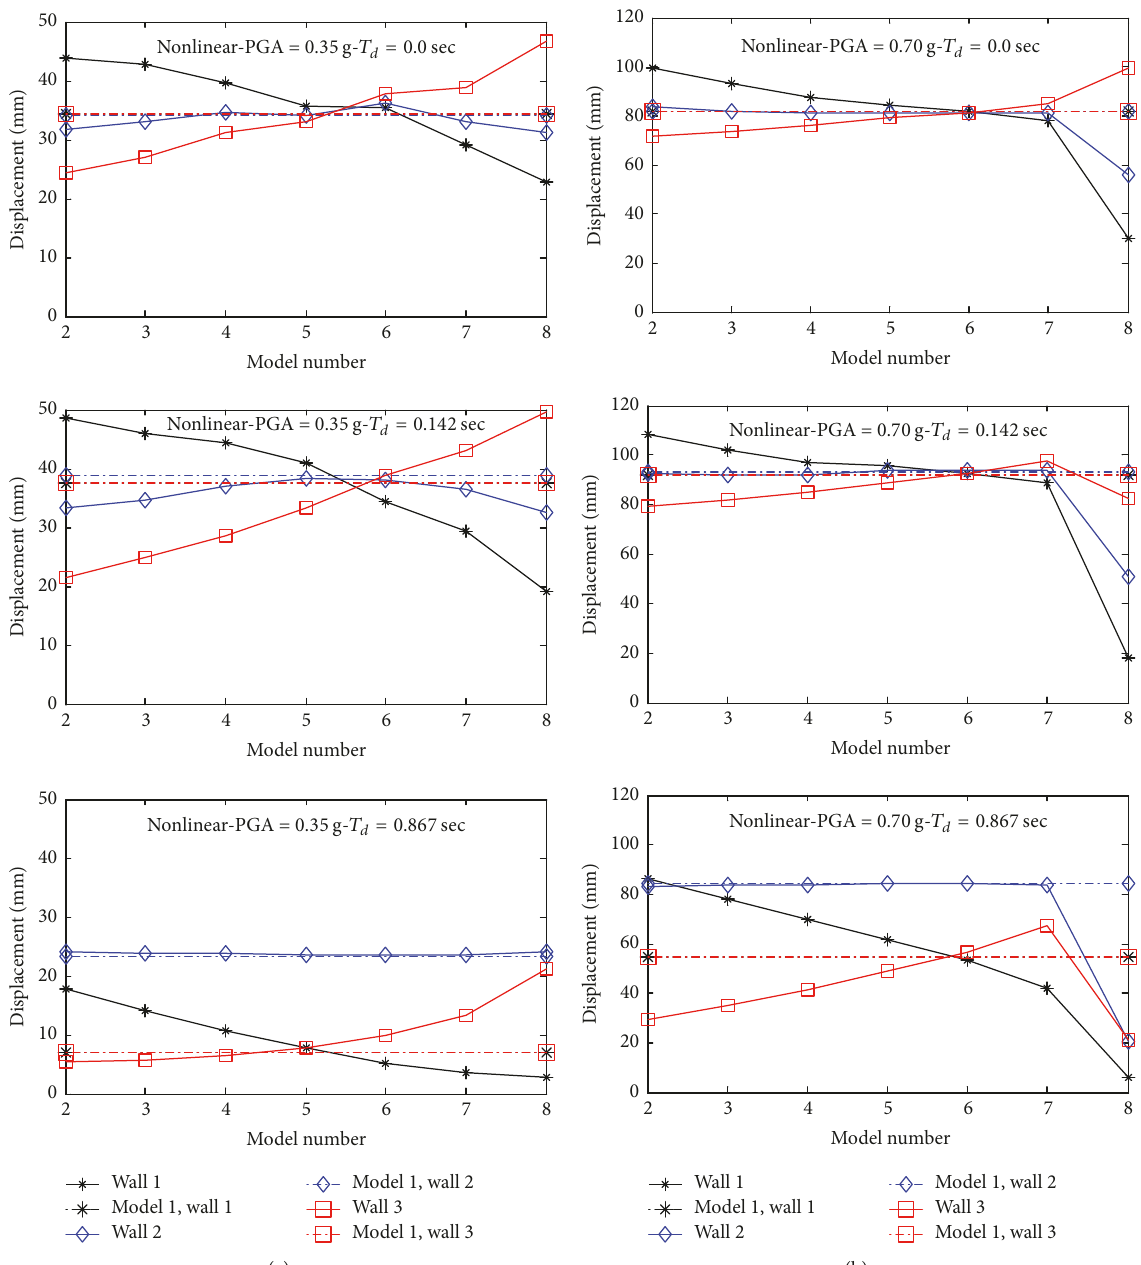
Figure 16: The mean of maximum displacements of walls in asymmetric structures: (a) DBE earthquakes (0.35 g) and (b) MCE earthquakes (0.70